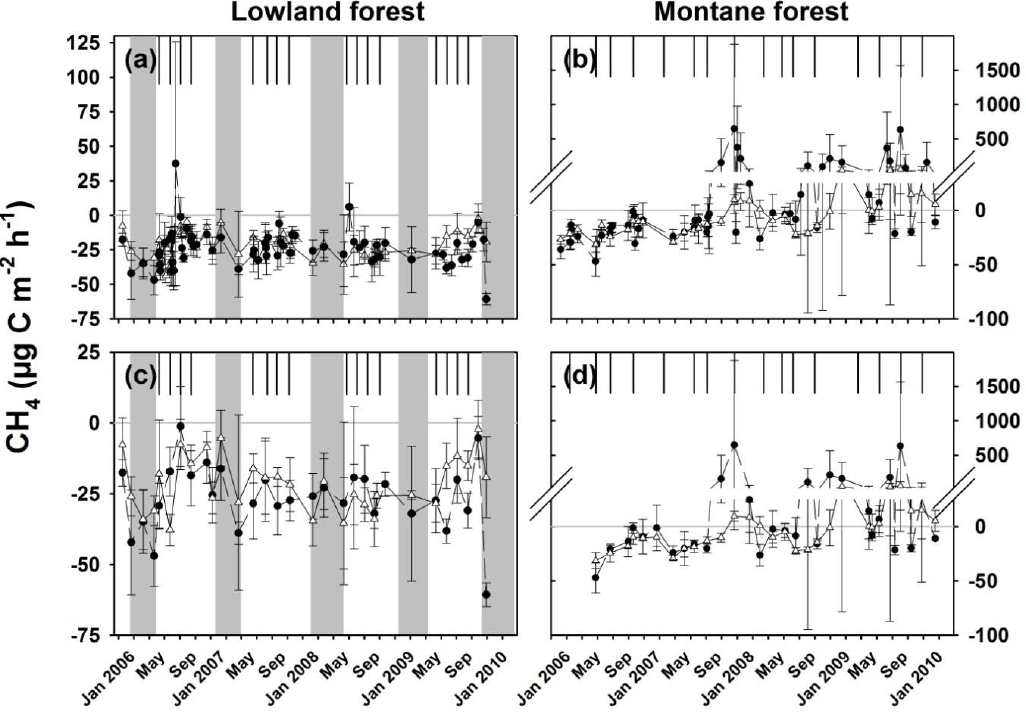
Fig. 3. Mean ( ± SE, n = 4) soil CH 4 -C fluxes from the control ( 4 ) and N-addition ( • ) plots of the lowland forest ( a and c ) and montane forest ( b and d ). The black vertical lines indicate dates of N addition during 9 to 12yr of treatment in the lowland forest and 1 to 4yr of treatment in the montane forest; the grey horizontal lines mark the zero flux. The upper panels include all fluxes whereas the lower panels show only the long-term fluxes, which were measured at least six weeks after a N addition. Grey shadings in (a) and (c) mark the dry